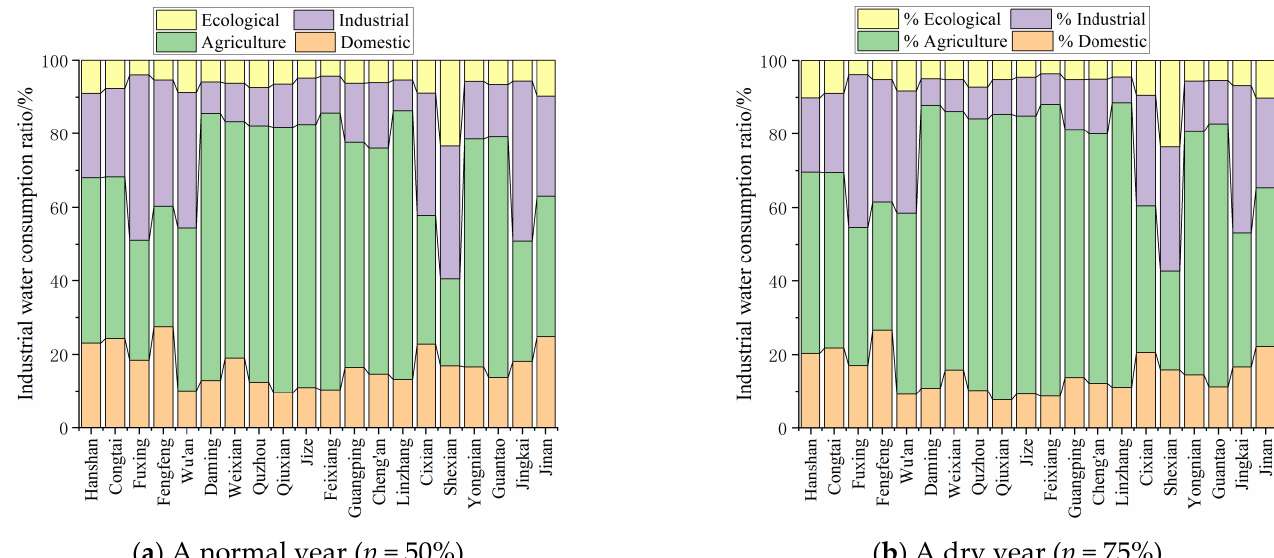
Figure 2. Prediction of water demand in 2025.